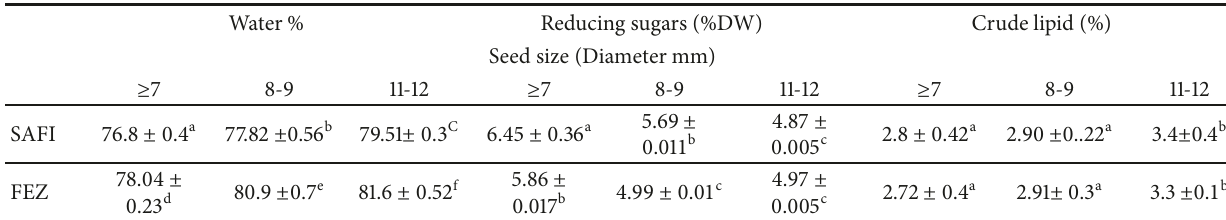
Table 3: Proximate composition of three different sizes of Capparis spinosa seeds from FEZ and